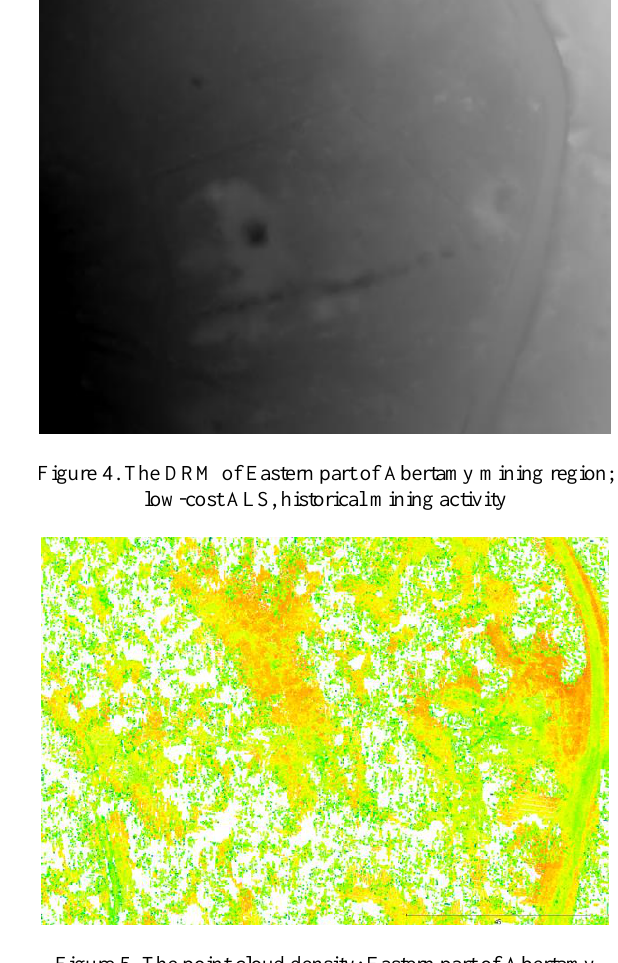
Figure 5. The point cloud density; Eastern part of Abertamy